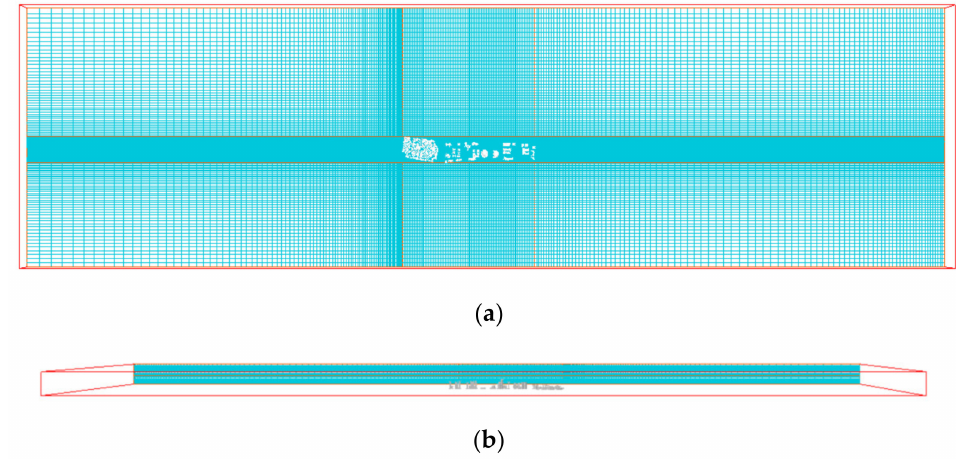
Figure 9. Grid discretization ( a ) x -axis and y -axis grid discretization; ( b ) z -axis grid